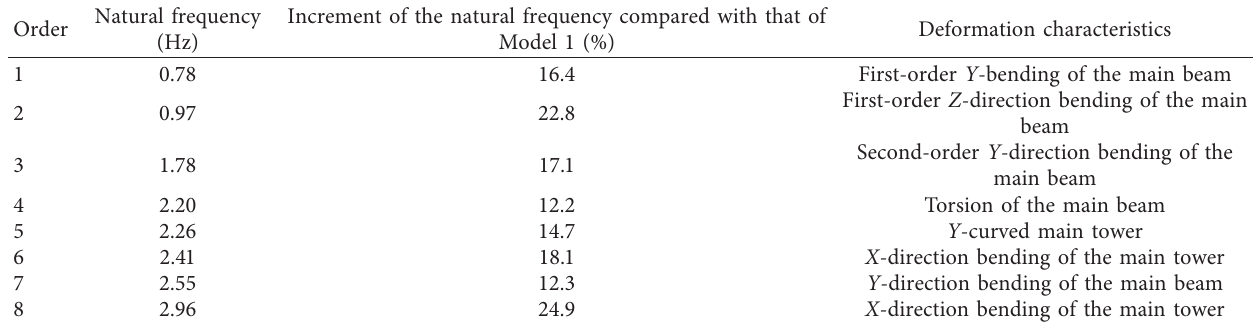
Table 3: Natural frequency and deformation characteristics of Model 3.